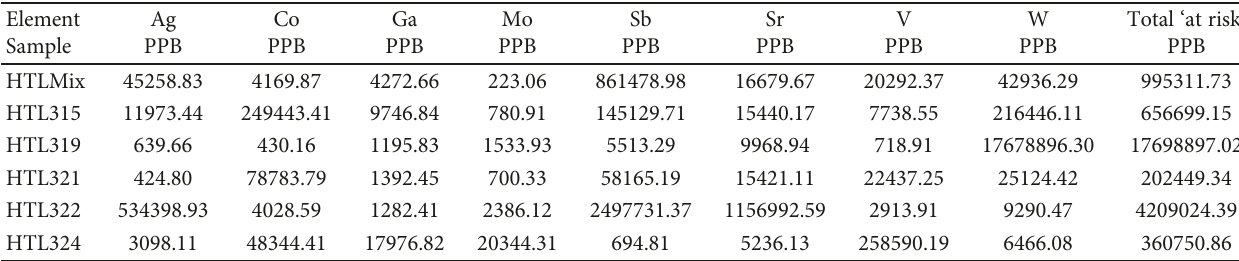
Figure 21: Comparison of rock sample composition to results from the batch and fl ow-through leaching experiments with deionised water and acetic acid as solvent. Important to note that the axis is logarithmic and the concentrations of “ common ” elements are in ppm and the concentrations of “ at risk ” elements are in ppb. Table 9: Concentration of the “ at risk ” elements in each solid rock